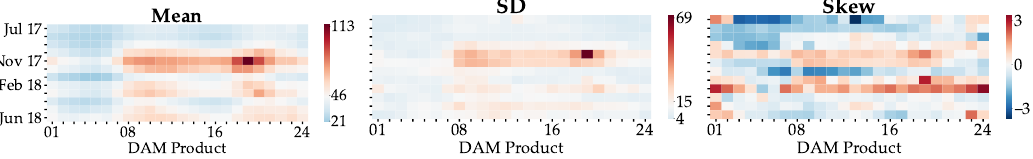
Figure 3. Scaled univariate kernel density estimates of daily model forecast RMSEs. Black curves present the distribution of forecast errors with the best TI features, while grey curves present benchmark model errors without TIs.